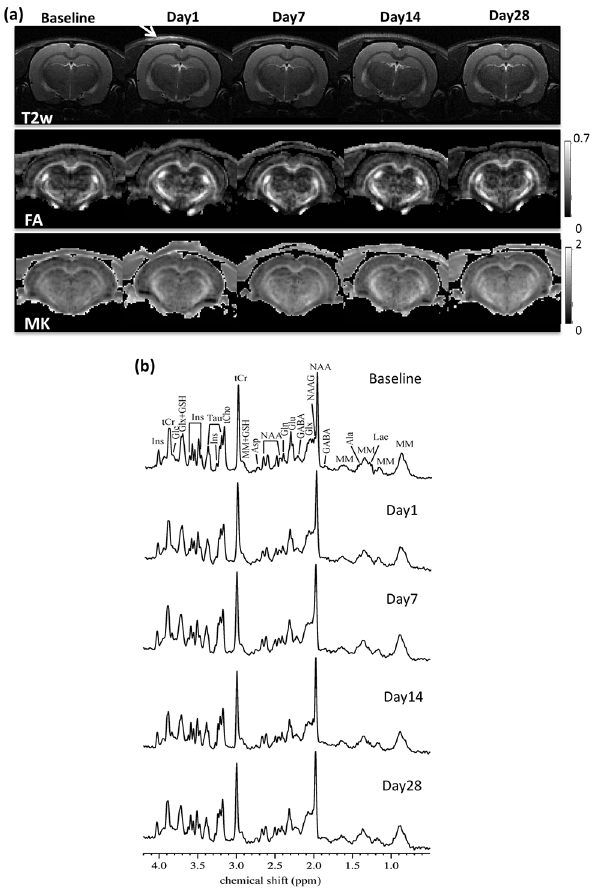
Fig 3. MRI data of a representative dc-bTBI rat at different time points from baseline to 28 days post injury. (a) T2w images, FA and MK maps from DKI for a coronal slice. Arrow indicated soft tissue contusion from the injury, which were apparent at Day1 on T2w images but has fully resolved by Day7. (b) In vivo proton MRS acquired in the hippocampus. alanine (Ala), asparttate (Asp), g-aminobutyric acid (GABA), glucose (Glc), glutamine (Gln), glutamate (Glu), glutathione (GSH), myo-inositol (Ins), lactate (Lac), N-acetylaspartate (NAA), N-acetylaspartylglutamate (NAAG), taurine (Tau), total creatine (tCr), choline compounds (tCho), glutamate/glutamine complex (Glx), and macromolecules (MM).